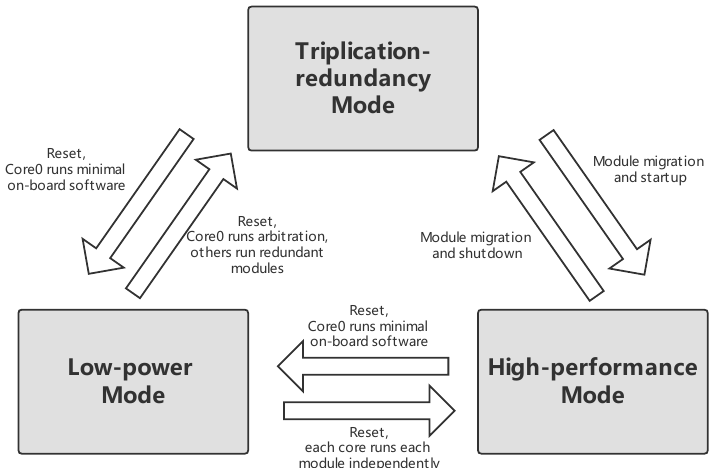
Figure 4. Switching between the three modes.